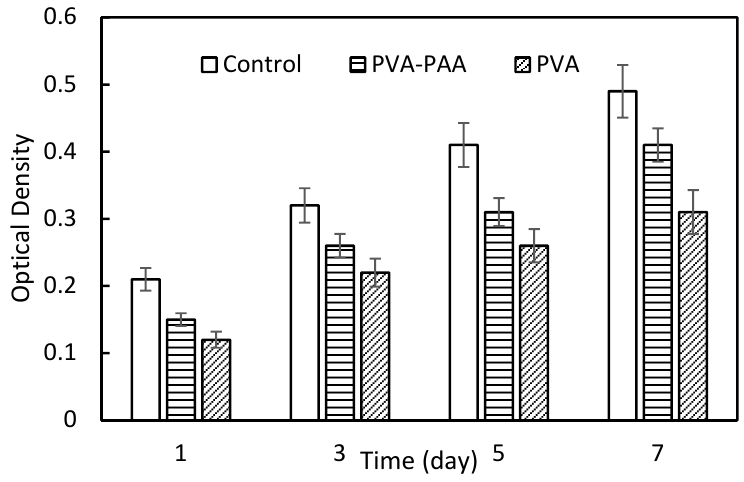
Figure 7. Biocompatibility analysis for PVA and PVA-PAA samples.